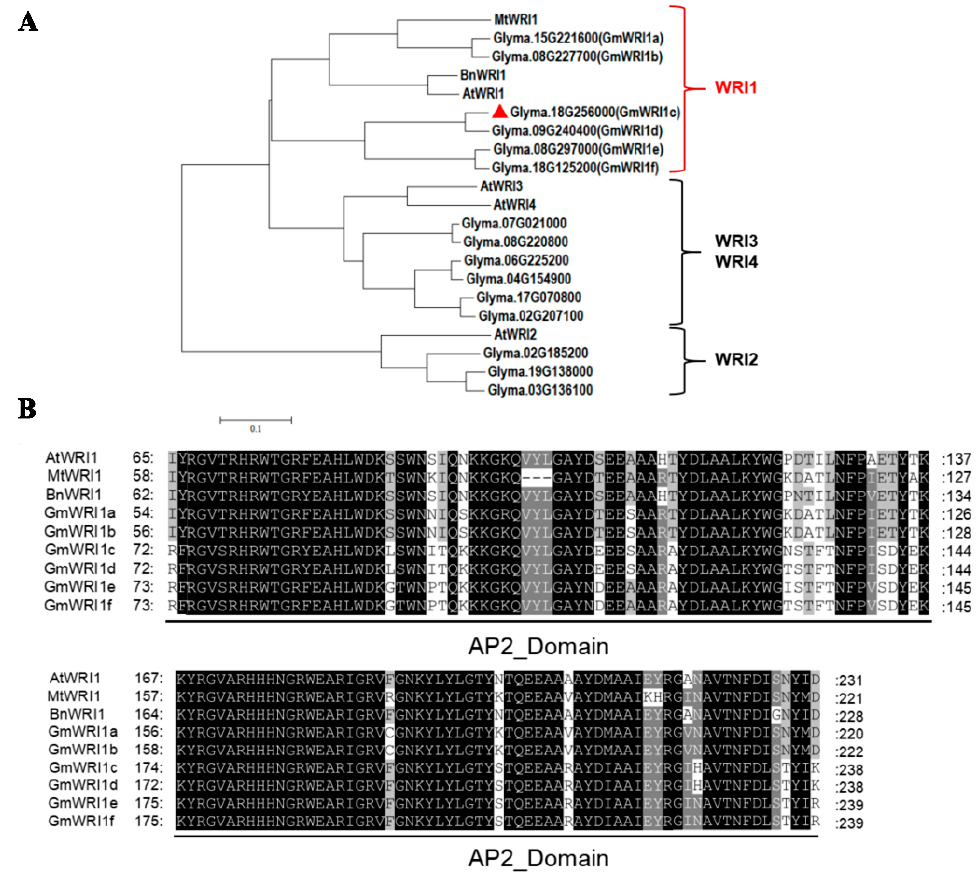
Figure 1. Phylogenetic and conserved domain analyses of GmWRI1s. ( A ) Phylogenetic tree of WRIs from Arabidopsis , soybean, Medicago sativa , and Brassica napus . ( B ) Conserved domain analysis of representative WRI1 proteins in Arabidopsis , soybean, M. sativa , and B. napus .